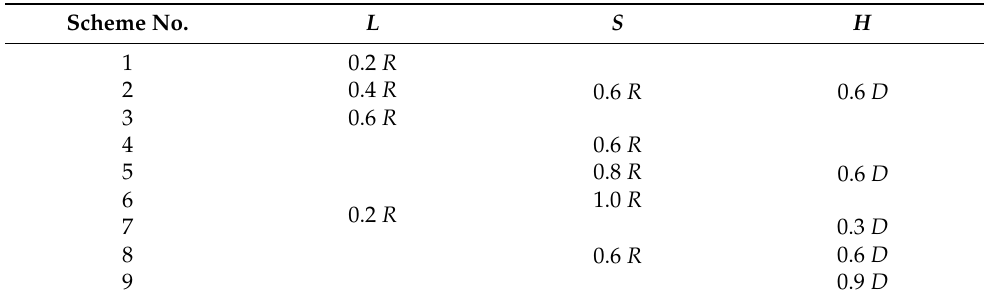
Table 3. Single-factor geometric parameter schemes. Scheme